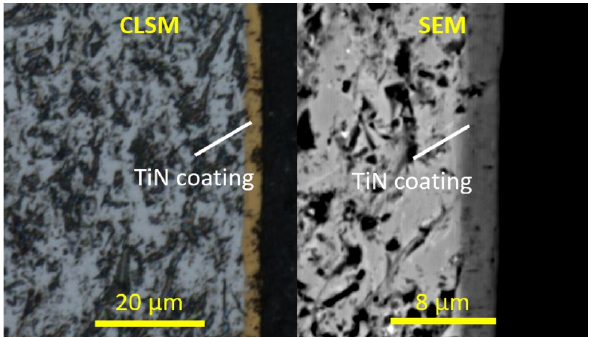
Figure 4: Measurement of PVD TiN coating thickness deposited on Ti6Al4V ELI biomedical titanium alloy (own research): left – confocal laser measuring microscope (CLSM), right – scanning electron microscope (SEM). Blurriness of the titanium nitride coating at the picture obtained by SEM can be seen.